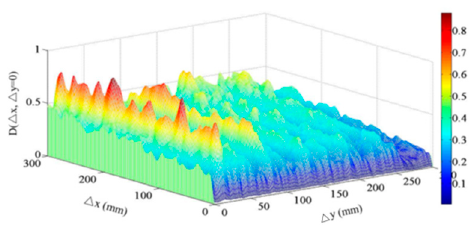
Figure 9. The second-order structure function of the bed elevation when the bed is in the initial state along the longitudinal